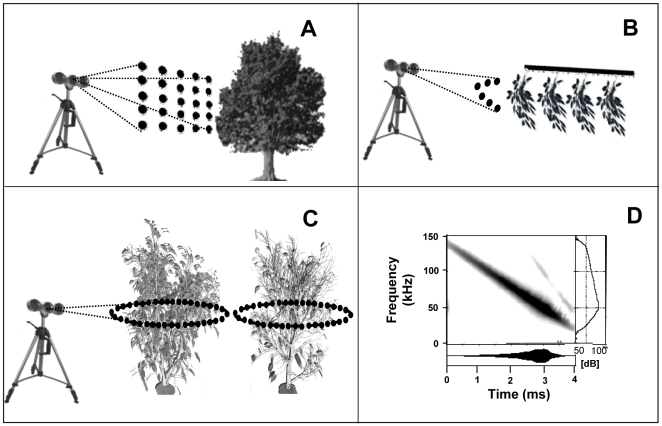
Summary of methods.A) Field data acquisition setting. The grid of points denotes the 25 acquisition positions used for each specimen. B) Ensonification of a plastic model plant from a single elevation angle and 5 horizontal angles. C) Ensonification of a Ficus plant with decreasing leaf density from 36 angles around the plant. Examples of 100% and 5% leaf coverage are shown. C) Time signal and spectrogram of the emitted signal.